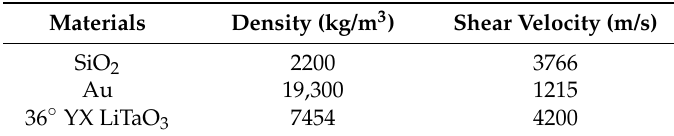
Table 1. Parameters of different